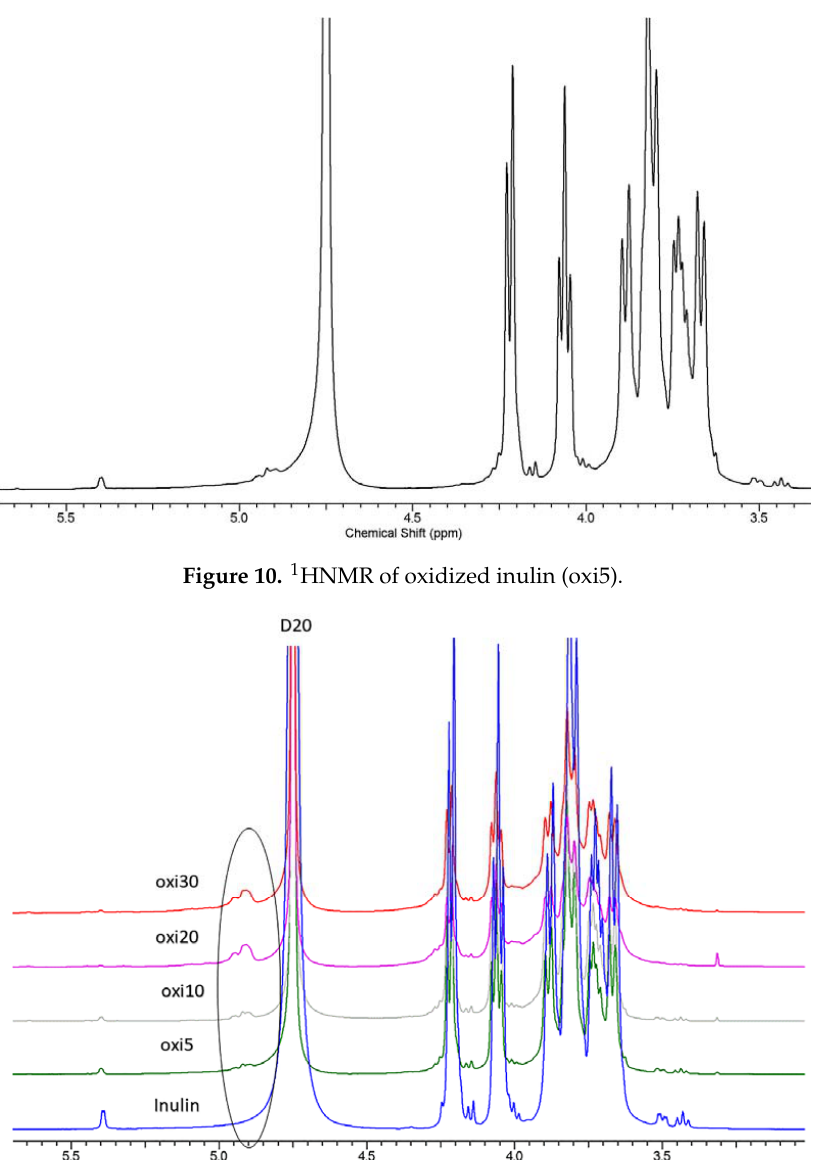
Figure 11. 1 HNMR of all oxidized inulin and the raw inulin.